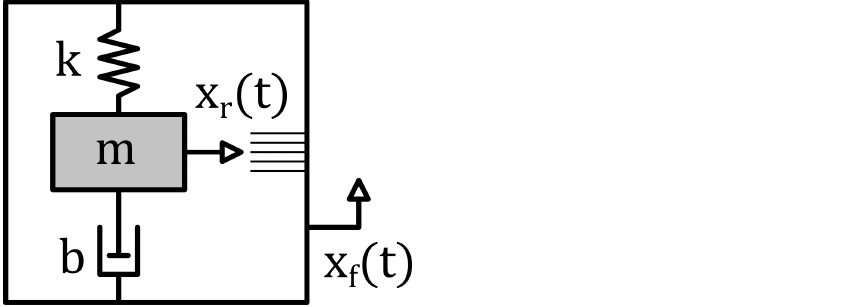
Figure 1. Schematic illustrating the inertial sensor concept